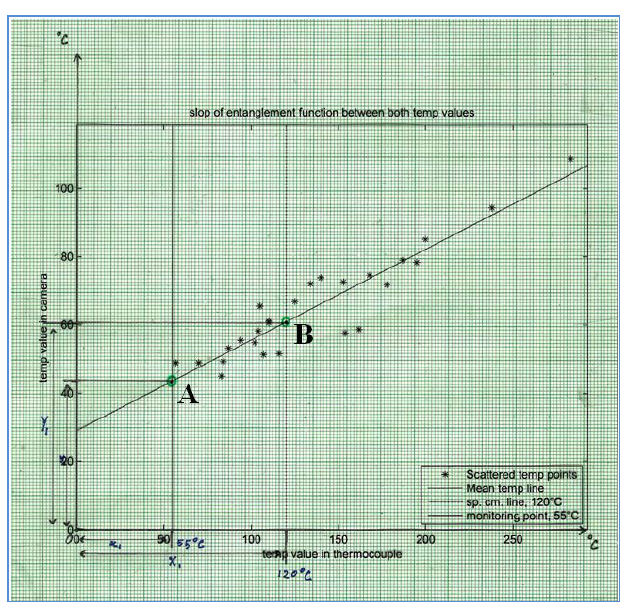
Figure 25. Respective temperature points detected by the